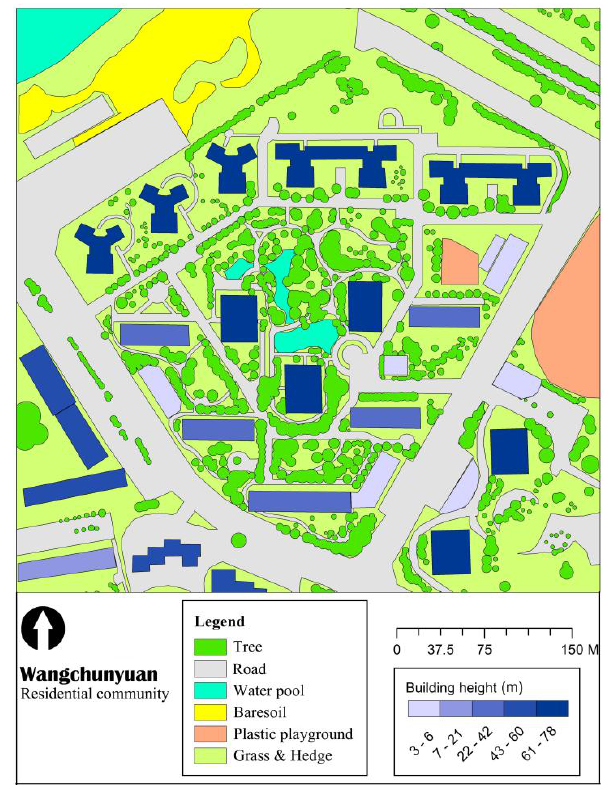
Figure 2. Land cover types of WCY and the surrounding area.